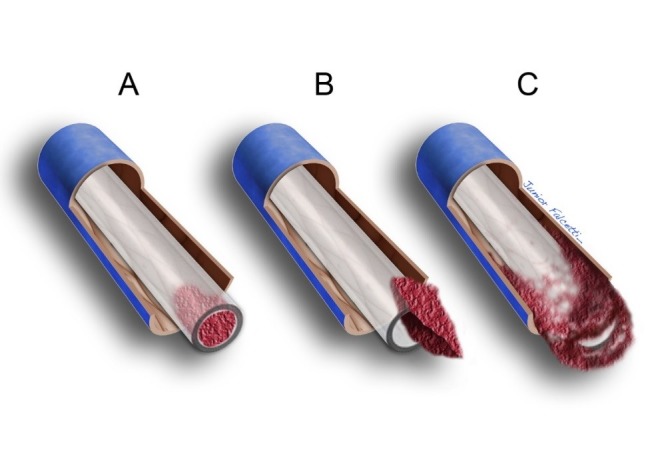
Formation of fibrin at the catheter tip; (A) Clot or fibrin inside the catheter lumen; (B) Thrombus primarily involving the external part of the catheter, which may act as a valve mechanism, preventing reflux of blood when negative pressure is generated; (C) Thrombosis enveloping the circumference of the tip of the device, significantly obstructing the catheter lumen.